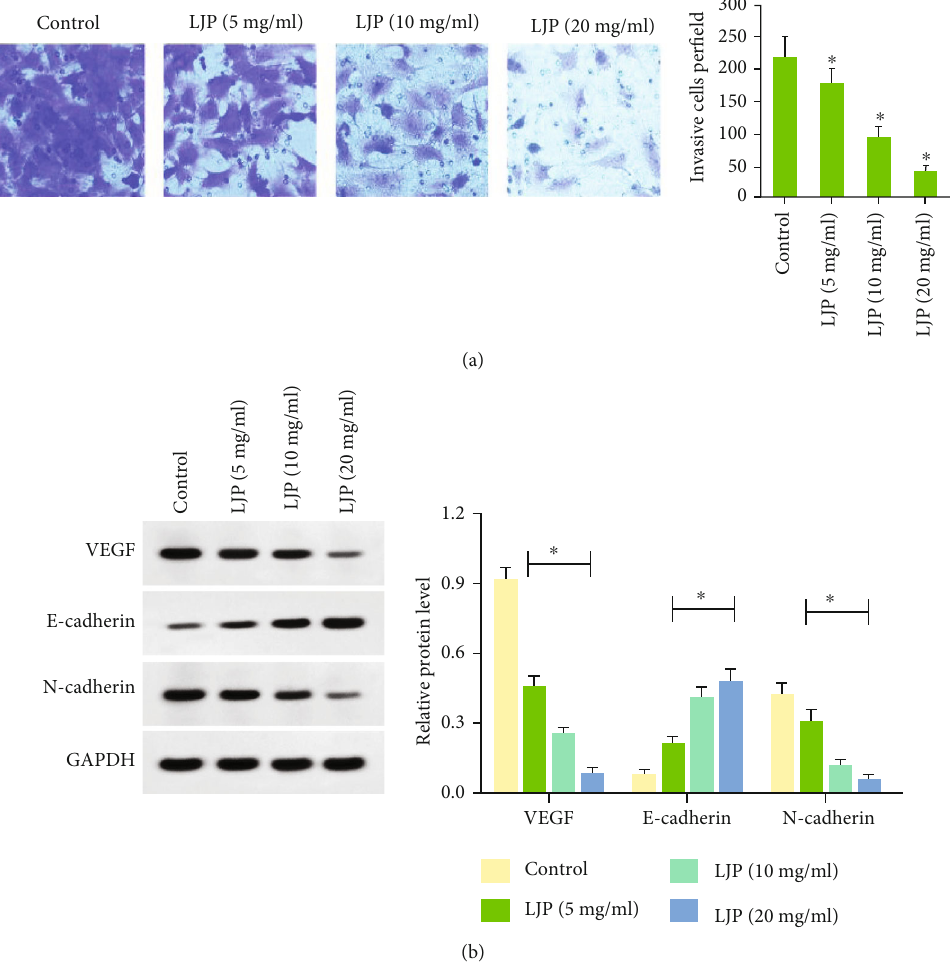
Figure 6: Expressions of EMT-related proteins. ∗ P < 0 : 05 versus control group. Transwell assay was used to detect invasive ability of A549 cells (a) and Western blot was used to detect expressions of EMT-related proteins (b) after treated with di ff erent concentrations of LJP for